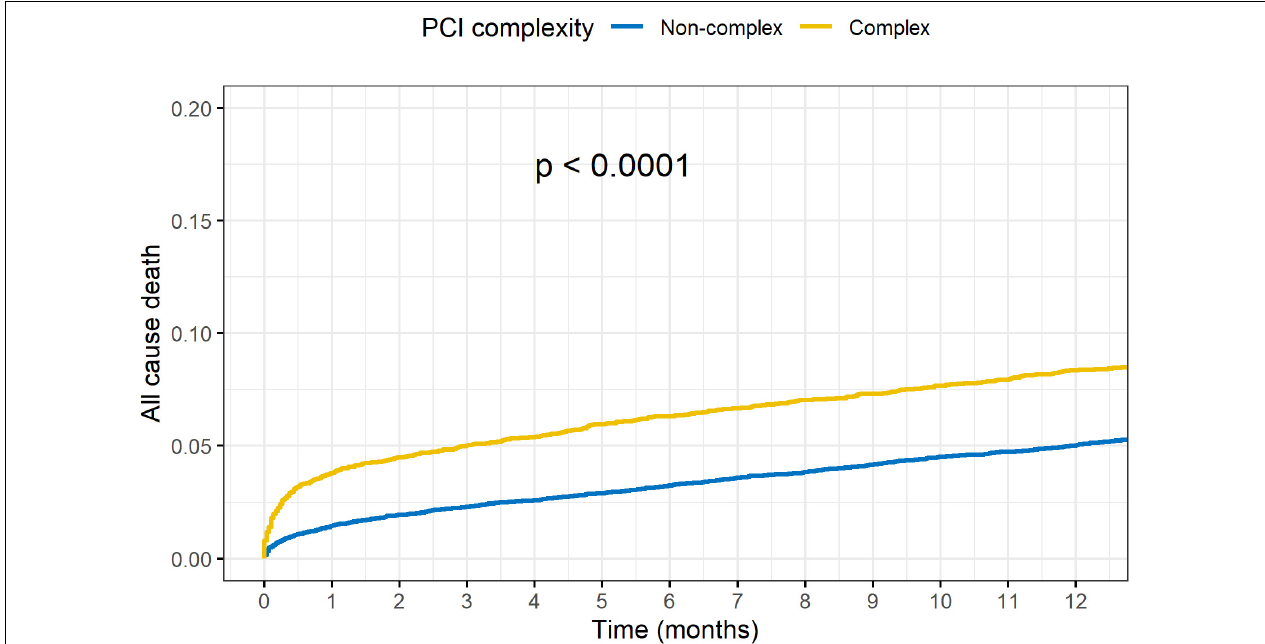
FIGURE 3 | Complex vs. non-complex